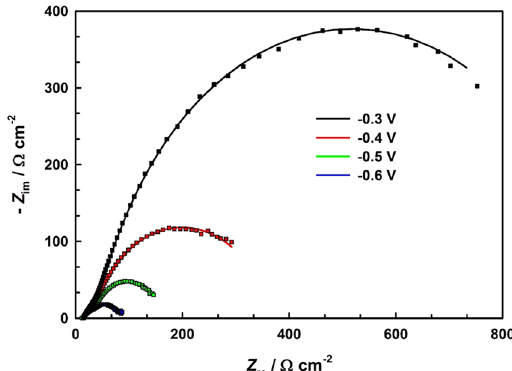
Figure 4. Nyquist plots of the optimized Cu-rGO nanocomposite electrode recorded at − 0.3, − 0.4, − 0.5, and − 0.6 V in a CO 2 saturated 0.1 M NaHCO 3 solution. The symbols denote the experimental data and the solid lines correspond to the fitted results using the equivalent electrical circuit (inset). The amplitude of the modulation potential was 10 mV and the frequency was altered from 100 kHz to 10